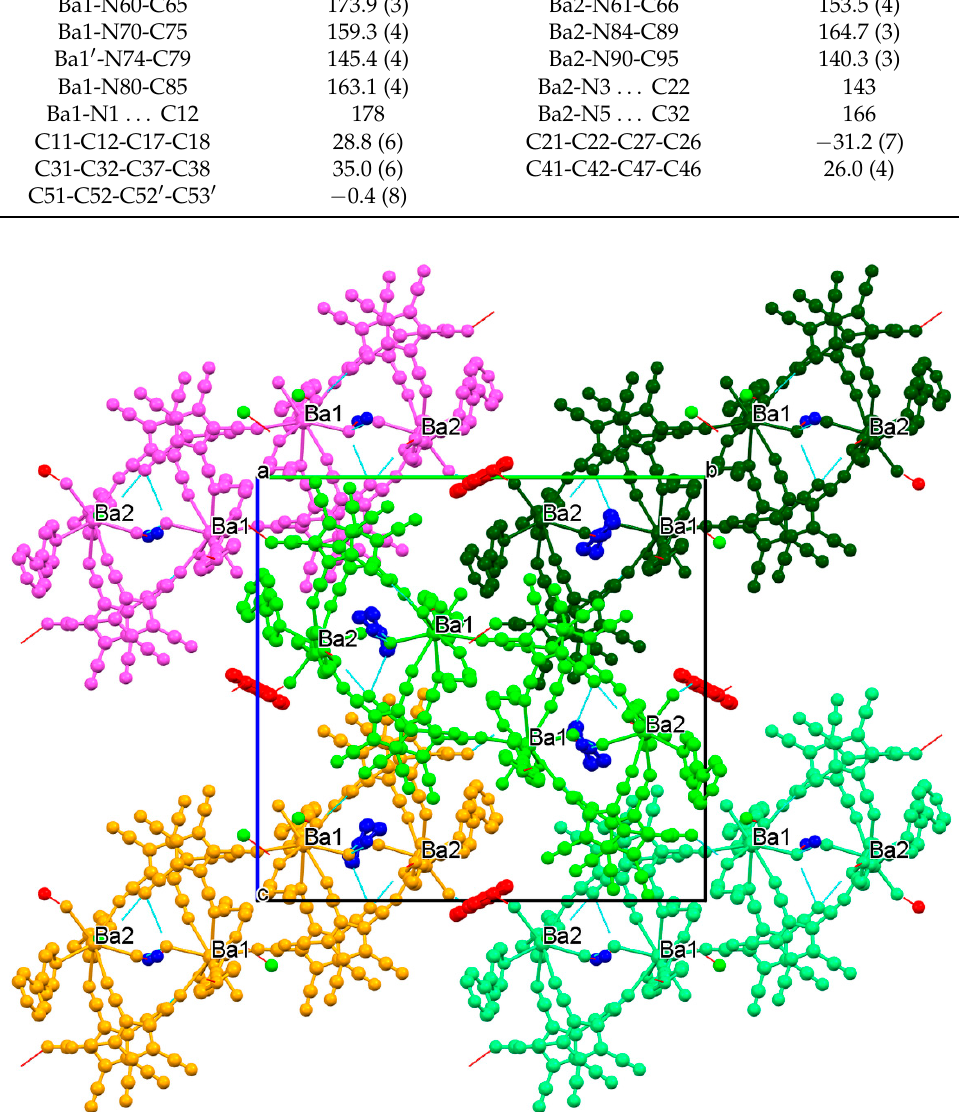
Figure 28. Complete packing plot (H atoms omitted as well as disordered BuOH molecules) of compound 6 , watched along a . Color coding: light-green. Dark green, turquoise, yellow, and magenta are five symmetry-related tetranuclear units, while red and dark blue are the uncoordinated bipyridines. Light-blue lines symbolize hydrogen bonds. Table 4 . Important bond parameters [Å, °] of compound 6 .